Question: Describe this figure in one sentence.
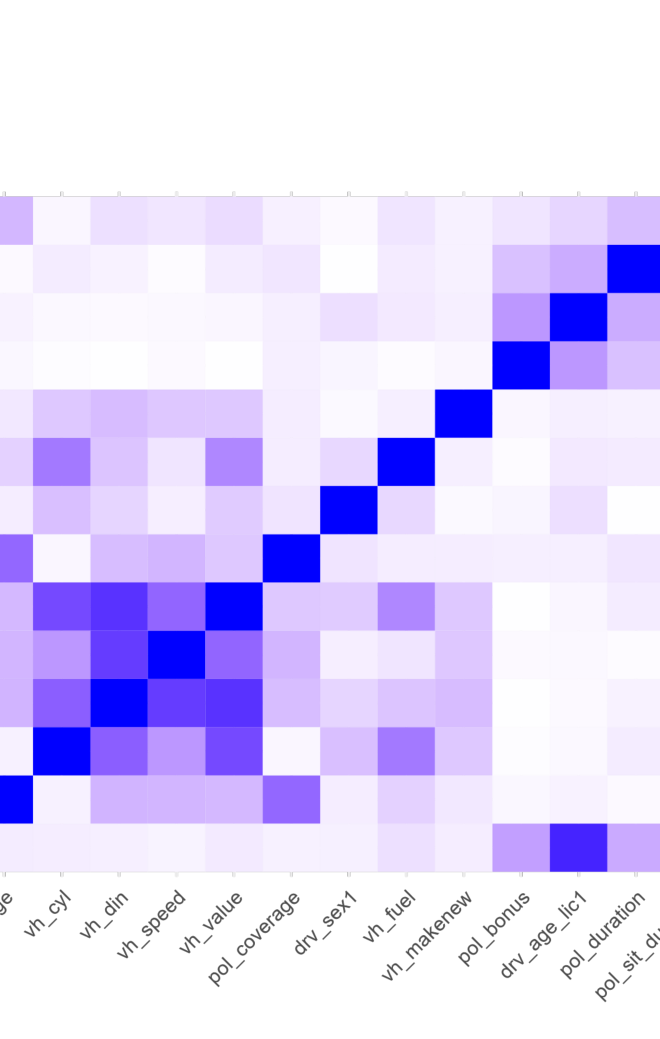
Answer: Correlation Matrix for the Insurance Data